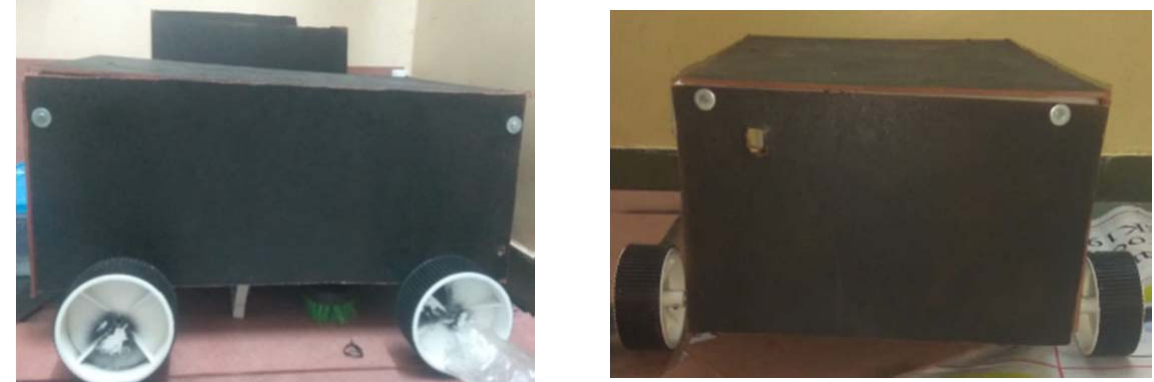
Figure 6. Side view and front view of prototype floor cleaner